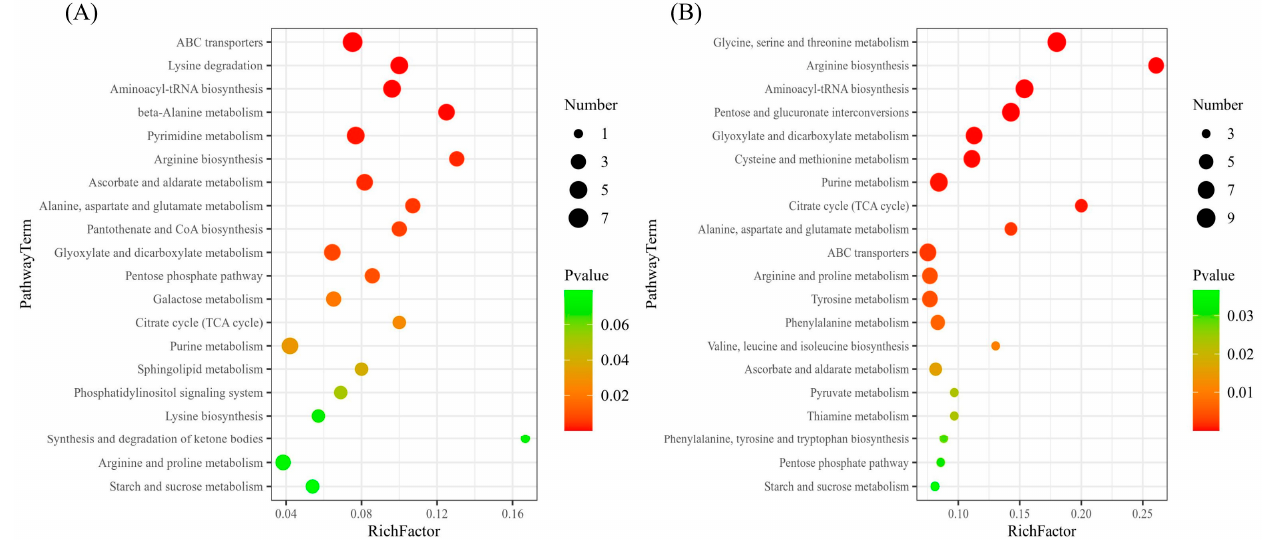
Figure 6. Enrichment pathway of different metabolites under different treatments. AM vs. CK ( A ), Cd-AM vs. Cd ( B ).